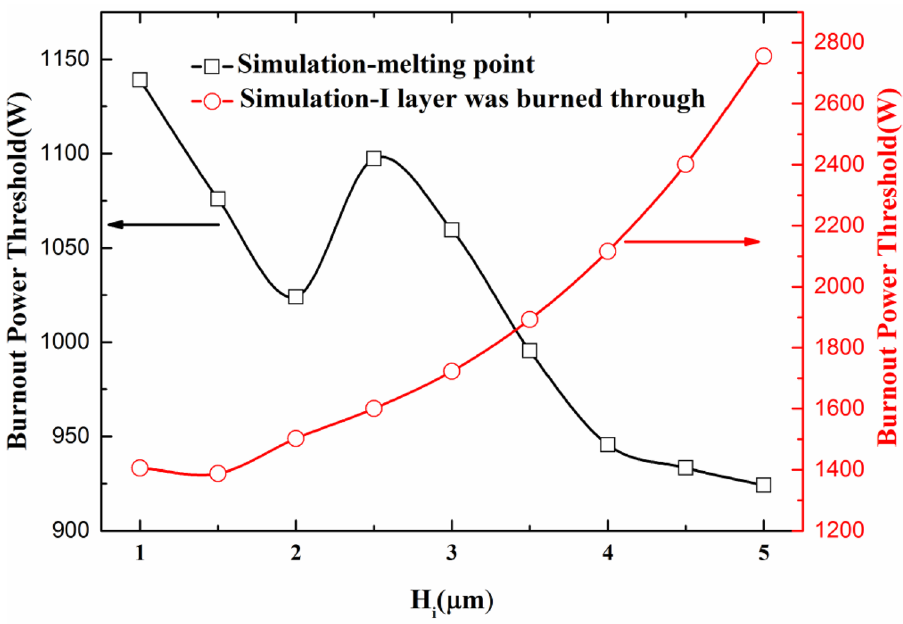
Figure 8. Simulation results of the relationship between the I layer thickness and the burnout power